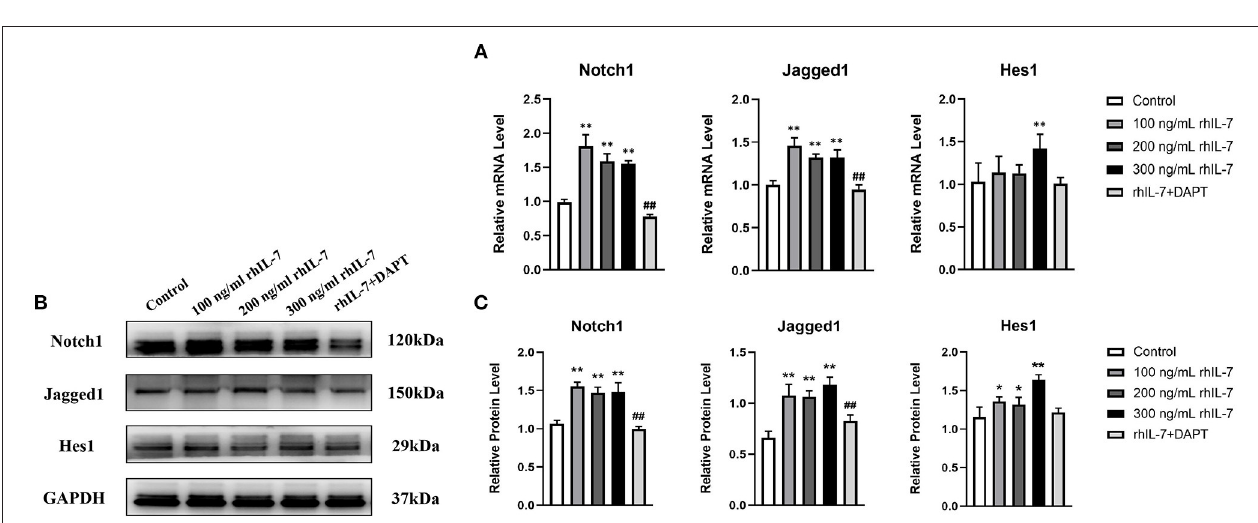
FIGURE 6 | Effects of treatment with different concentrations of rhIL-7 in hPDLCs on Notch1 signaling pathway-related molecules. (A–C) After hPDLCs were treated with different concentrations of IL-7 for 24h, the mRNA level and protein level of Notch1, Jagged1, and Hes1 were detected by RT-qPCR and WB. n = 3, * p < 0.05. ** p < 0.01. ## DAPT group compared with 200ng/mL rhIL-7 group, p < 0.01. hPDLCs, human periodontal ligament cells; RT-qPCR, reverse transcription quantitative PCR; WB, Western blot.